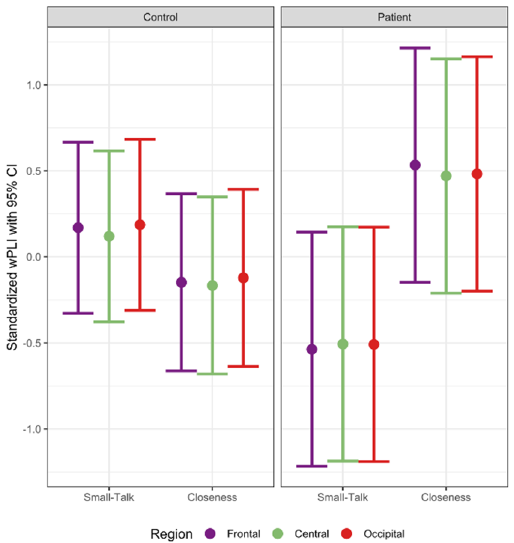
Figure 1. Theta connectivity strength.